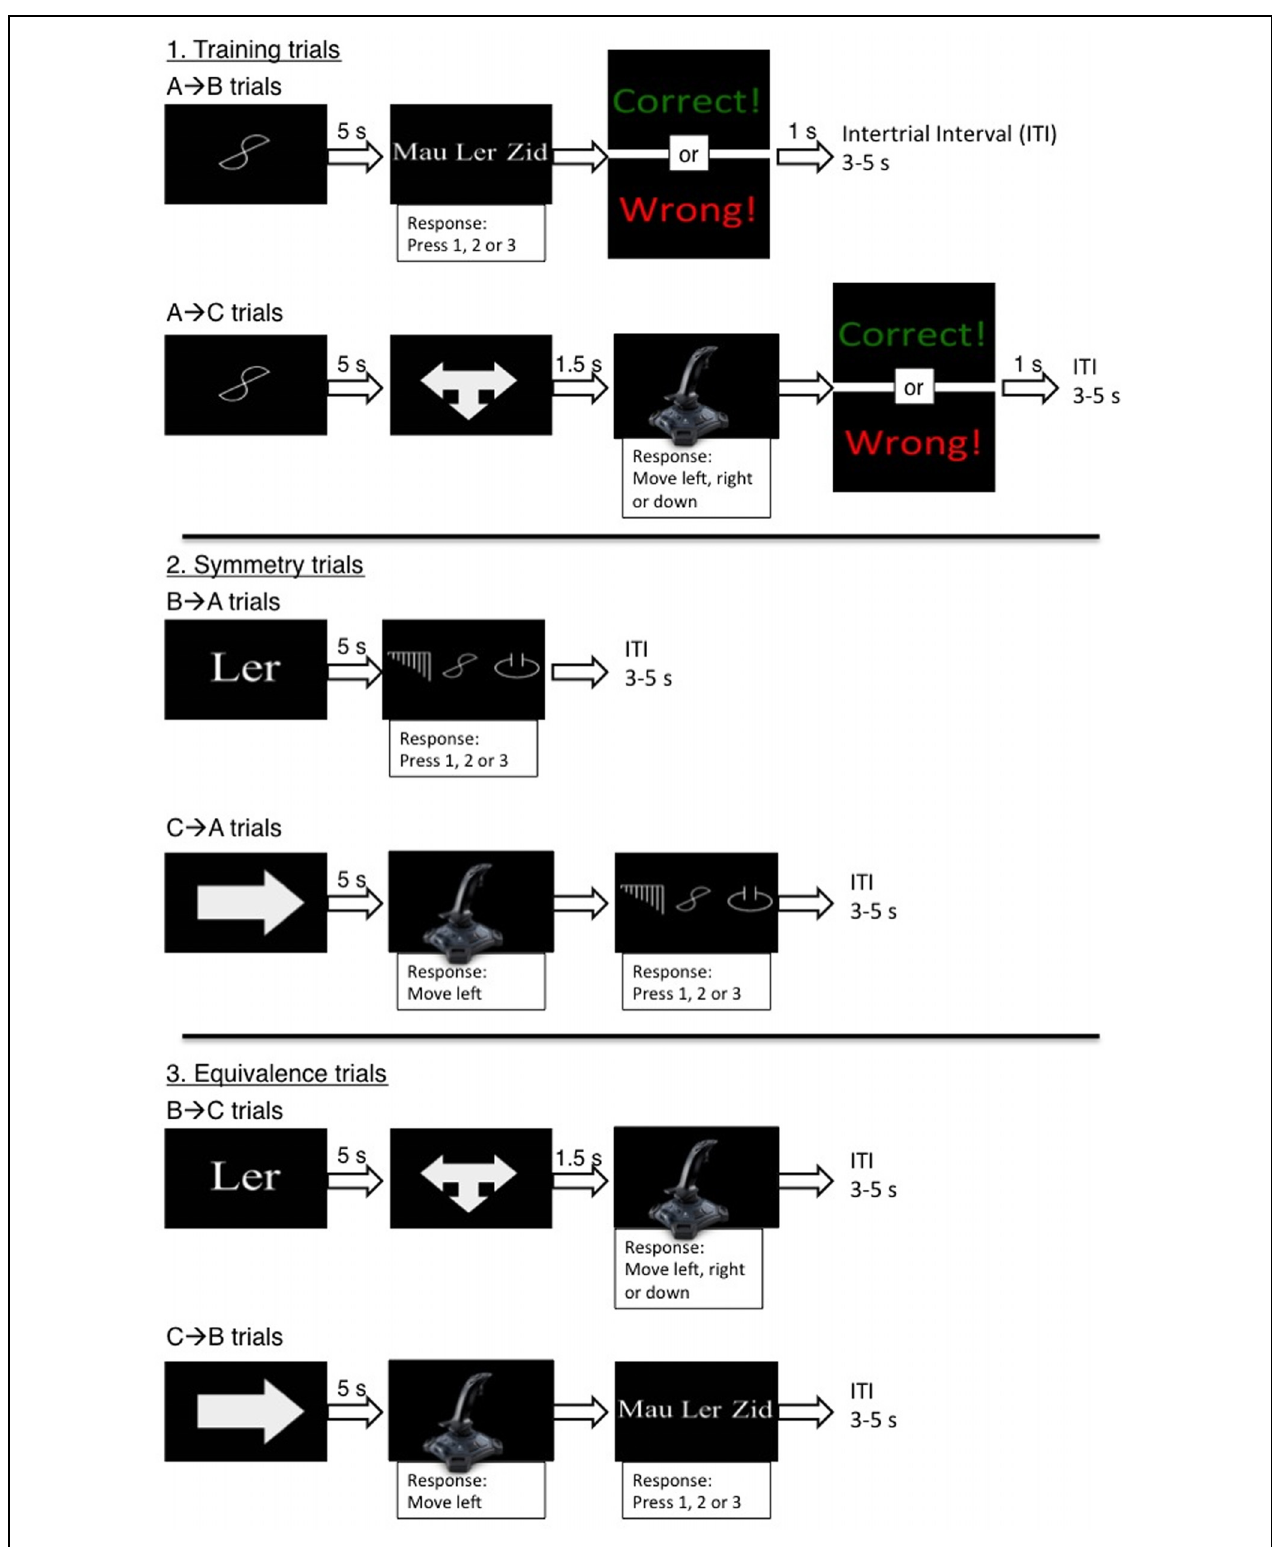
FIGURE 2 | A schematic overview of the matching-to-sample (MTS) task trials. The three different panels depict the trial formats for the different MTS phases; (1) training trials, (2) symmetry trials, and (3) equivalence trials. Within each panel is a depiction of the